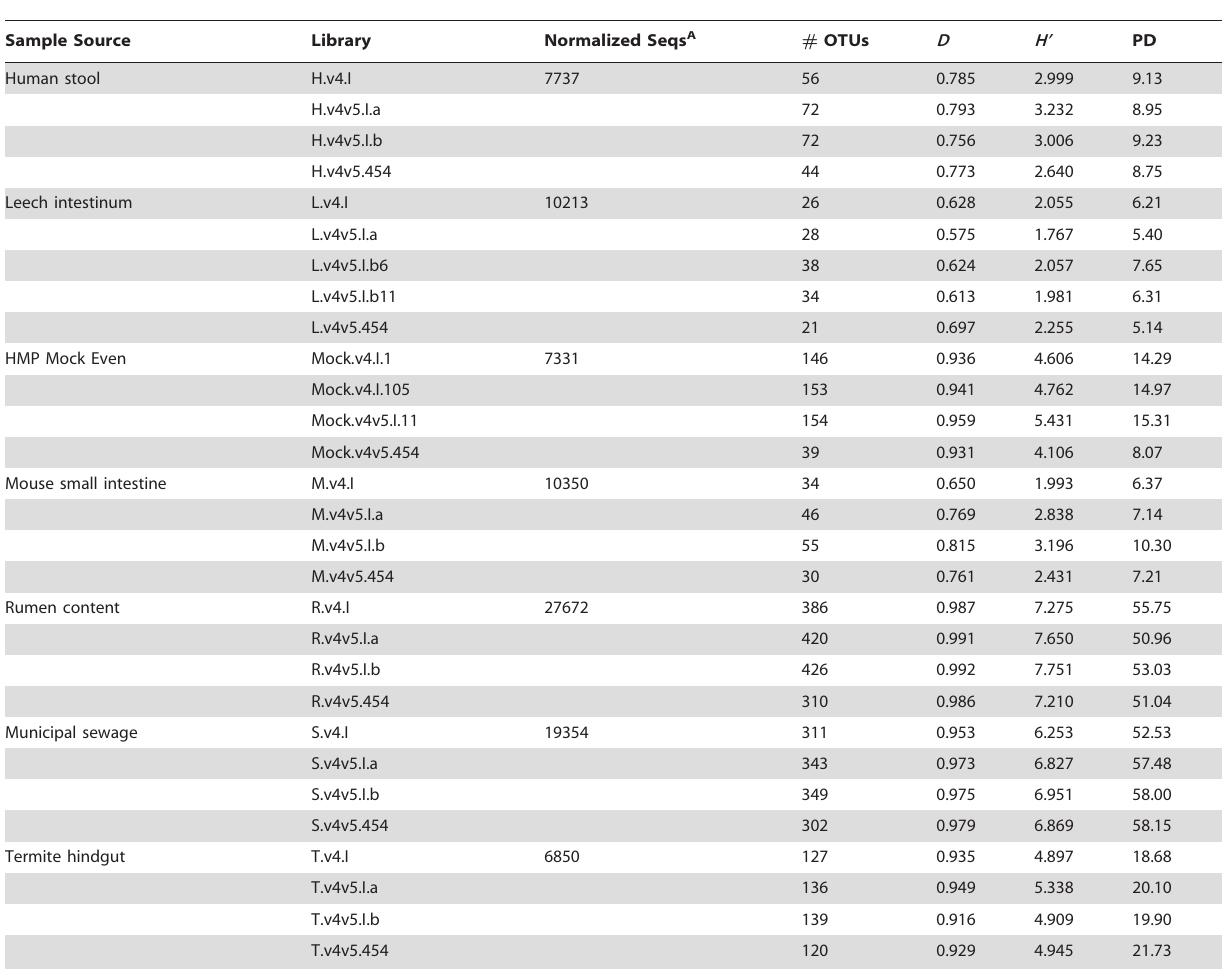
Table 3. Alpha diversity measures of RDS processed samples after normalization.